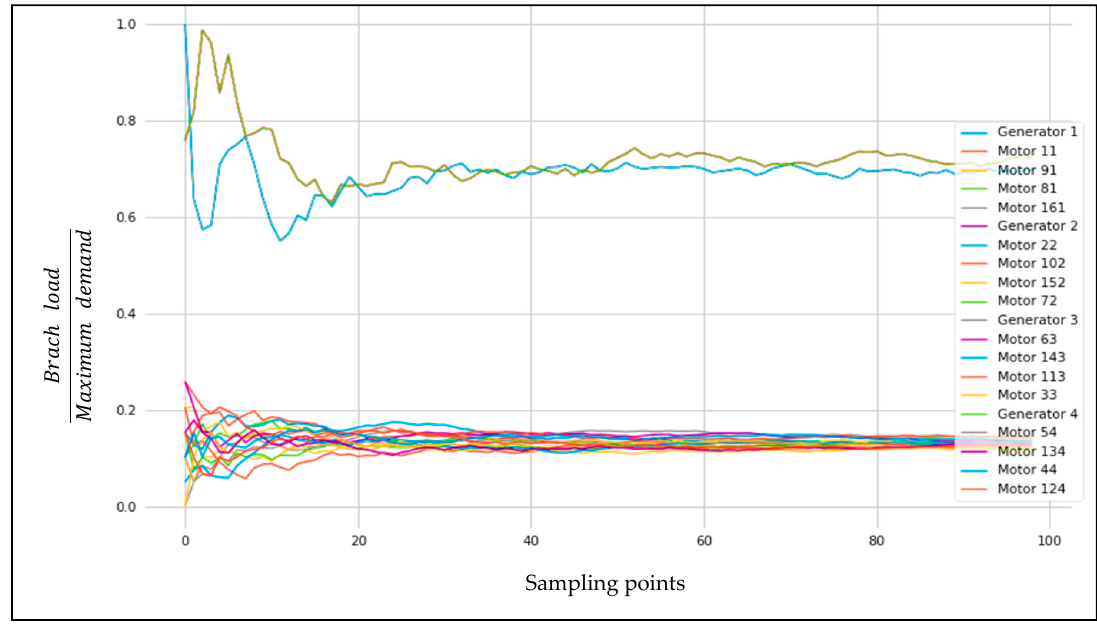
Figure 16. TO Latin hypercube branch loading average for TeDP NASA N3-X.